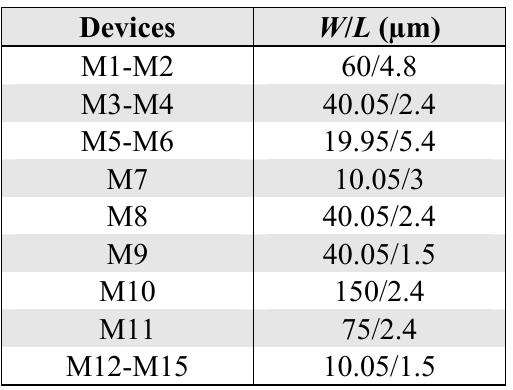
Table 1. Aspect ratio (length/width) of the transistors for the proposed